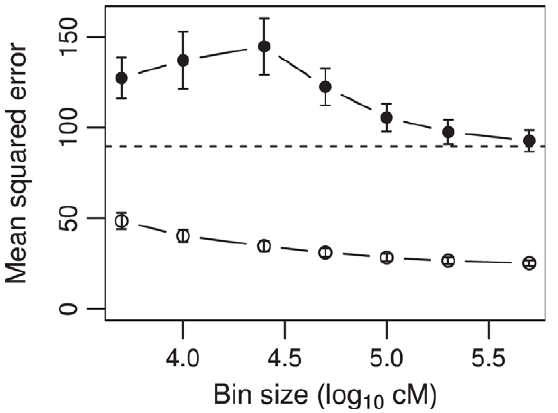
Figure 5. Mean squared error for the simulated data under design IV plotted against the bin size. Design IV was for populations with low levels of linkage disequilibrium. The sample size of the simulated population was n ~ 500 . The residual error variance was s 2 ~ 20 , corresponding to h 2 ~ 0 : 777 . The filled circles indicate the MSE under the infinitesimal model while the open circles indicate the MSE under the adaptive infinitesimal model. The dashed horizontal line represents the phenotypic variance of the simulated trait (89.71).